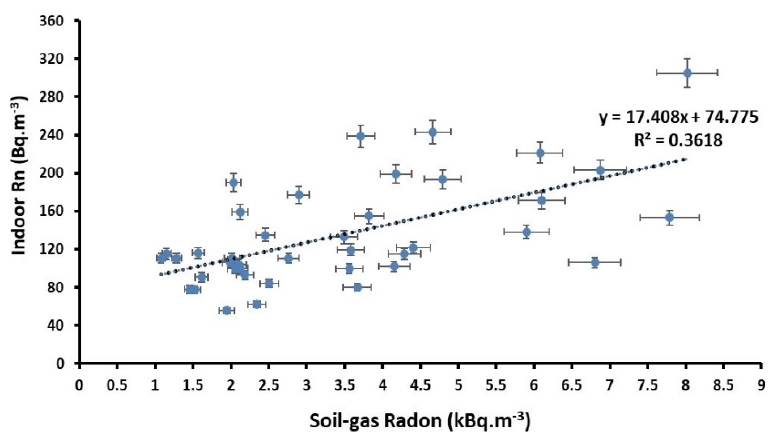
Figure 6. The correlation between indoor radon and soil-gas radon concentrations.